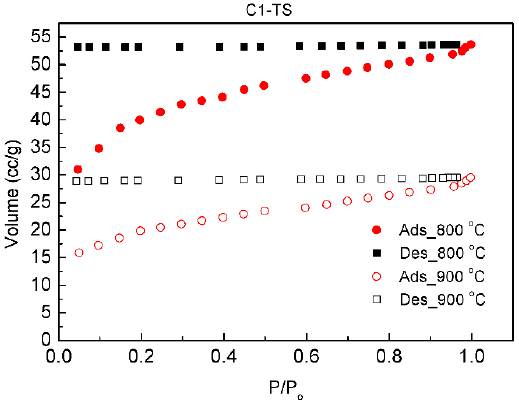
Figure 3. N 2 physisorption isotherms for sample C1-TS pyrolyzed at 800 °C and 900 °C. The N 2 physisorption isotherms for sample C2-Fe pyrolyzed at 500 °C and 800 °C are shown in